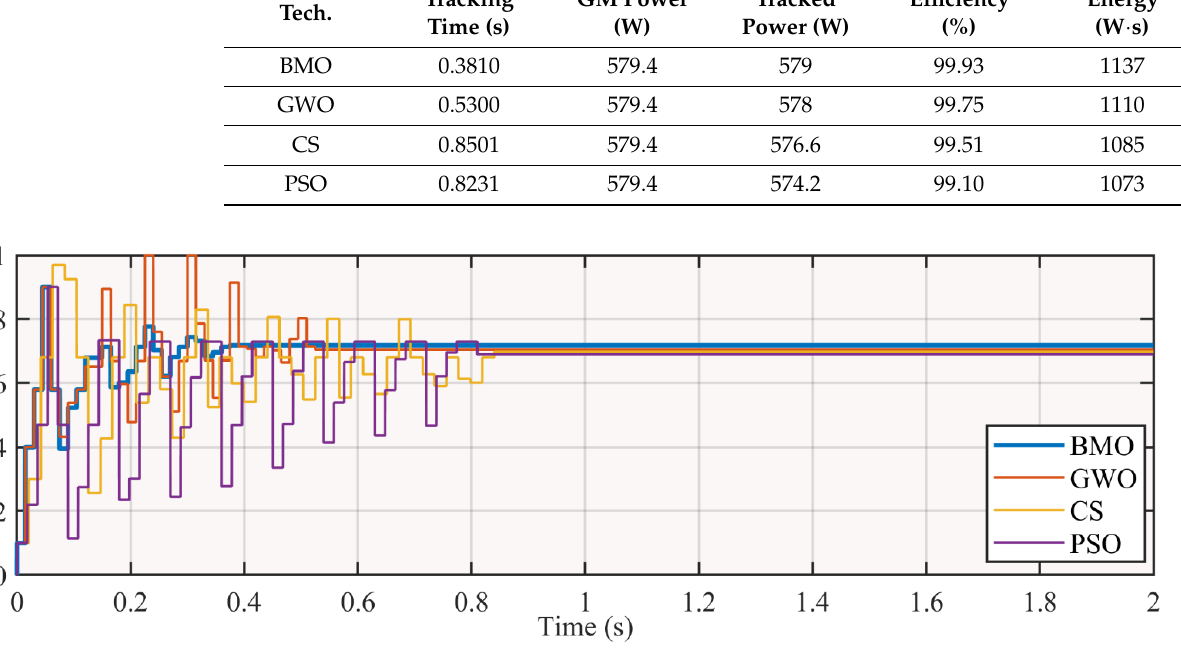
Figure 9. Competing techniques duty cycle Case-1.